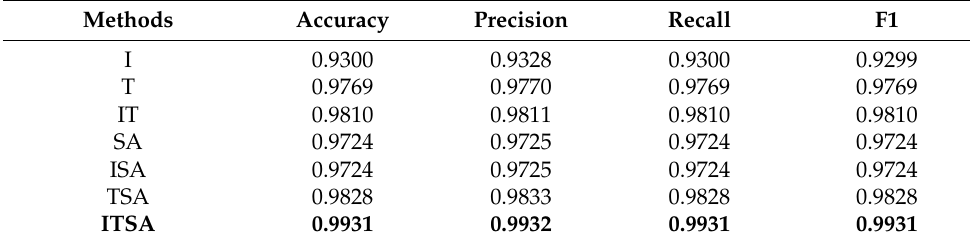
Table 6. Results of different data fusion